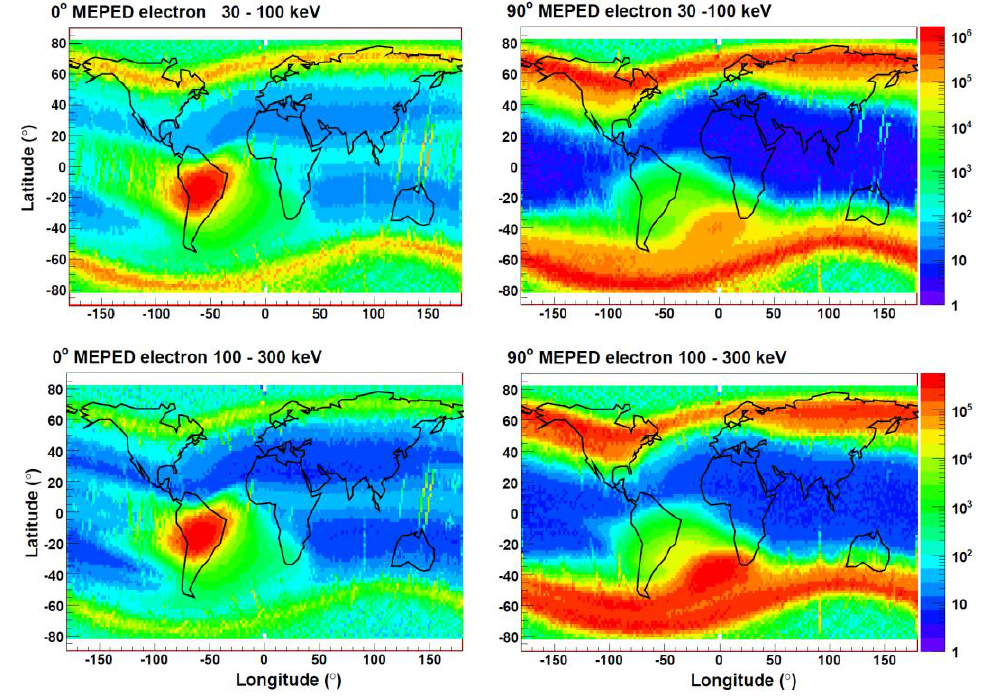
Figure 1. The average electron flux (cm 2 s −1 sr −1 MeV −1 ) in geographical coordinates. Channels are defined in orientation directed towards the zenith (0°) and perpendicular to the direction of the satellite motion and zenith, in energy with respect to the bands 30–100 keV and 100–300 keV. The scale on the right indicates the average annual (2003) electron flux. The red spot of the 0° electrons (left) represents the SAA where the satellite go through the inner VAB (L < 2) and so the detected electrons are trapped particles. Similarly, near the poles, trapped particles are also visible with the lobes in the 90° electrons (right), differences in shape was given from the pitch angle